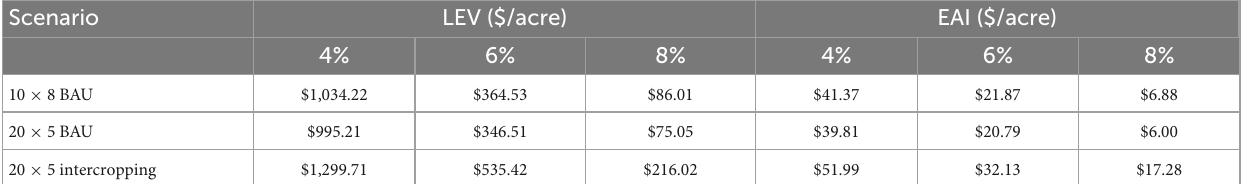
TABLE 6 Land expectation value (LEV) and equivalent annual income (EAI) of the evaluated scenarios under the discount rate of 4%, 6%, and 8%.